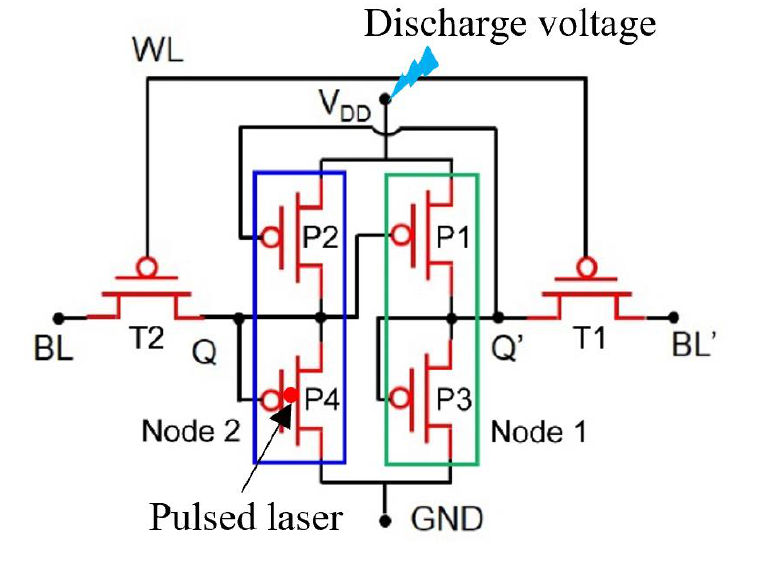
Figure 9. Schematic diagram of SRAM structure with SEE and